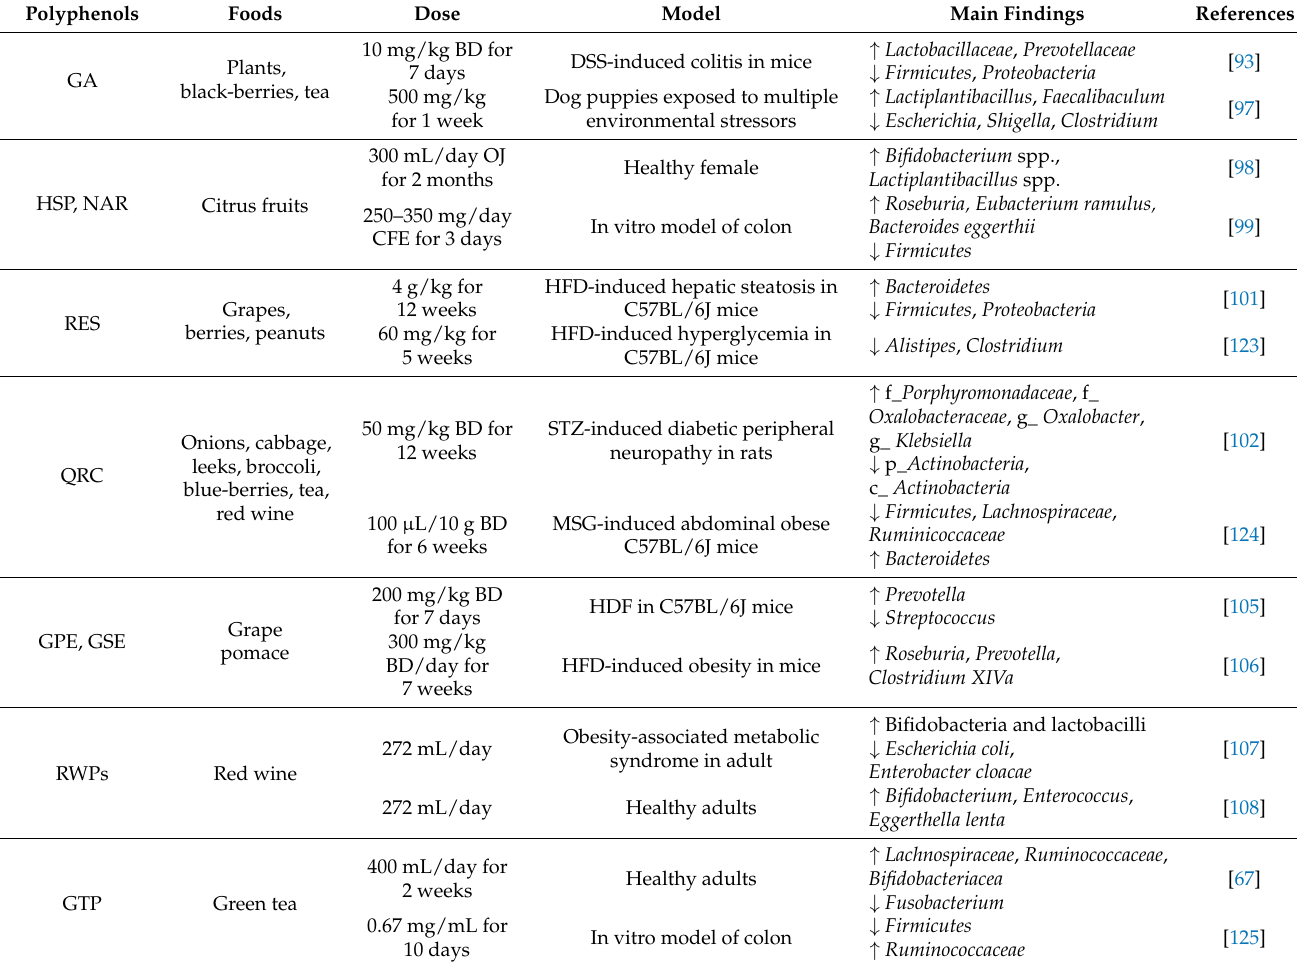
Table 1. Main studies on the impacts of polyphenols on the gut